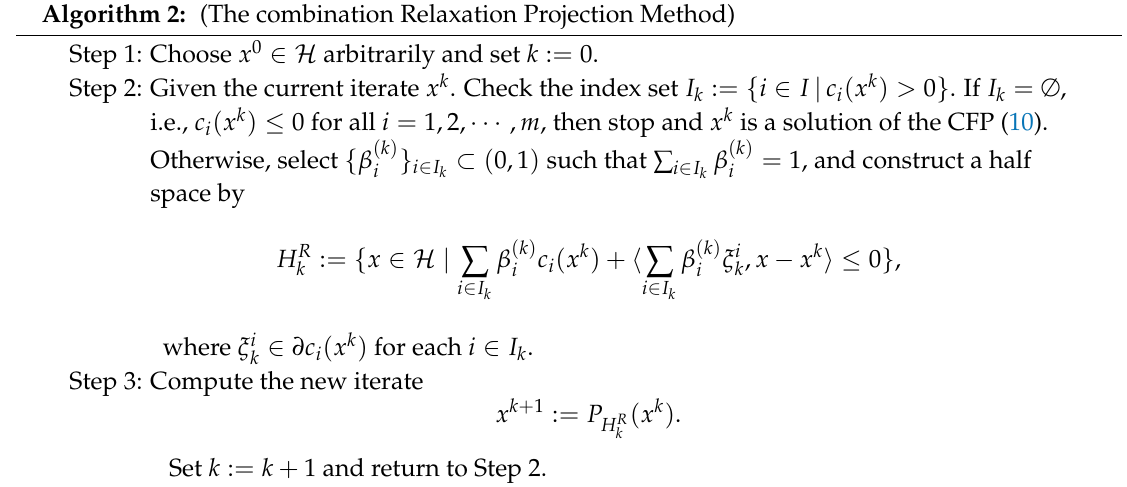
Algorithm 2: (The combination Relaxation Projection